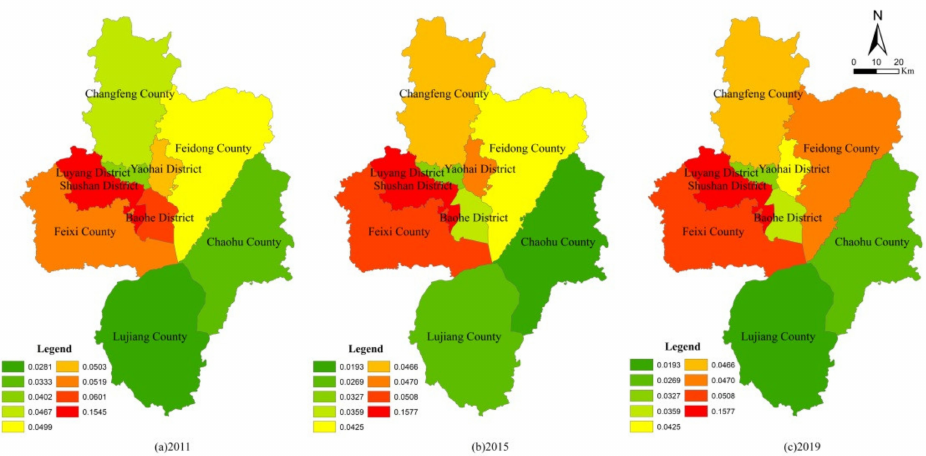
Figure 5. Production function evaluation results of districts and counties under carbon constraint.